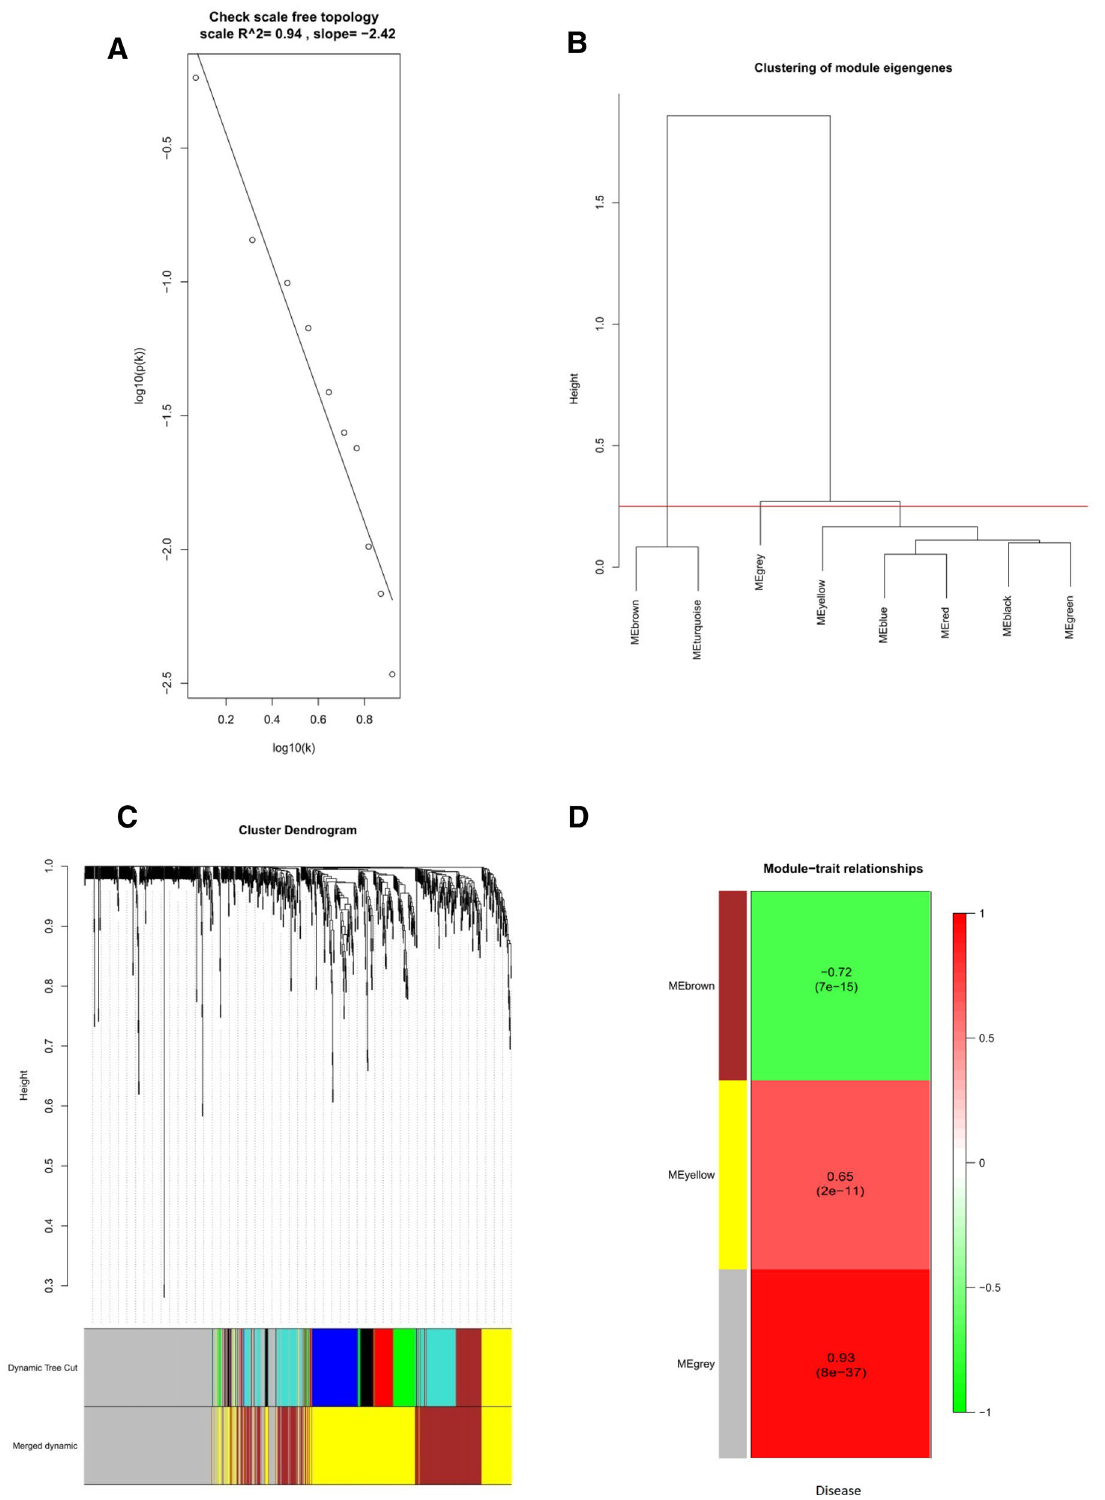
Figure 3. The WGCNA of 878 overlapping DEGs between the UC group and the control group. ( A ) Scale-free networks checking, R 2 > 0.9. ( B Module clustering dendrogram. The module is merged with the cutoff value of 0.25. ( C ) Module clustering dendrogram. Each branch in the figure represents one gene, and every color below represents one co-expression module. ( D ) The correlation between each module with UC disease